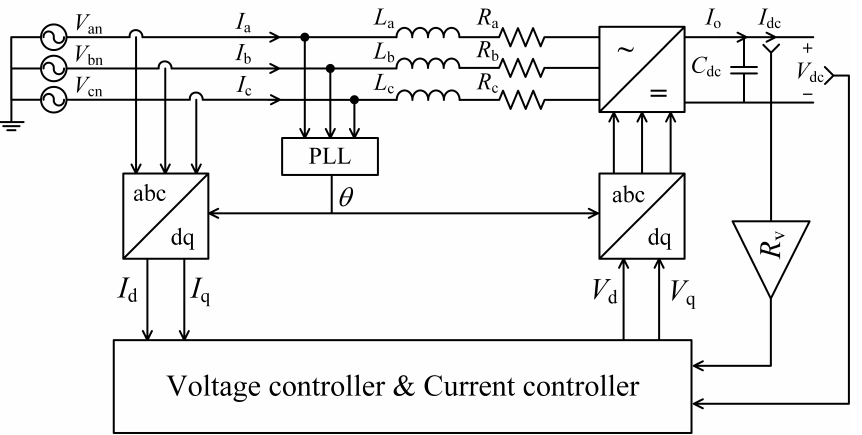
Figure 1. The control structure of a voltage droop controlled grid-forming VSC.